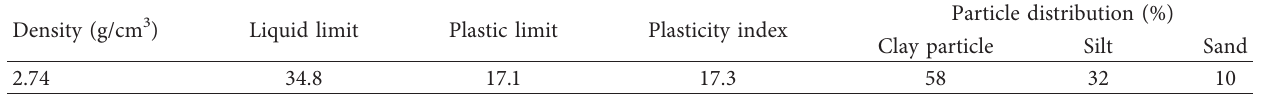
Table 1: Physical properties of soil samples.